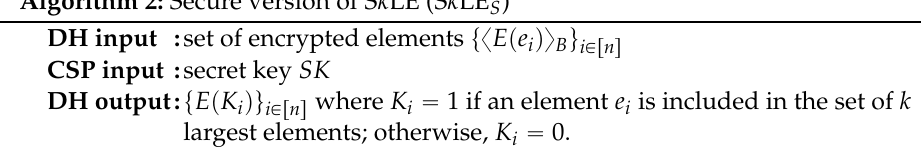
Algorithm 2: Secure version of S k LE (S k LE S